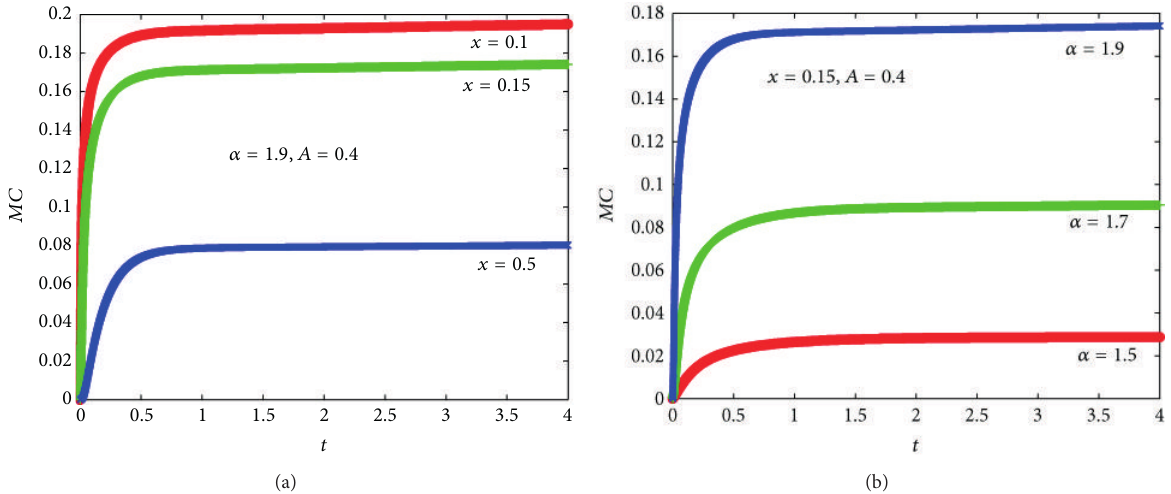
Figure 5: (a) is 𝑀𝐶 , plotted against 𝑡 at different 𝑥 when 𝛼 = 1.9 , 𝐴 = 0.4 ; (b) is 𝑀𝐶 , plotted against 𝑡 at 𝑥 = 0.15 for different values of 𝛼 .